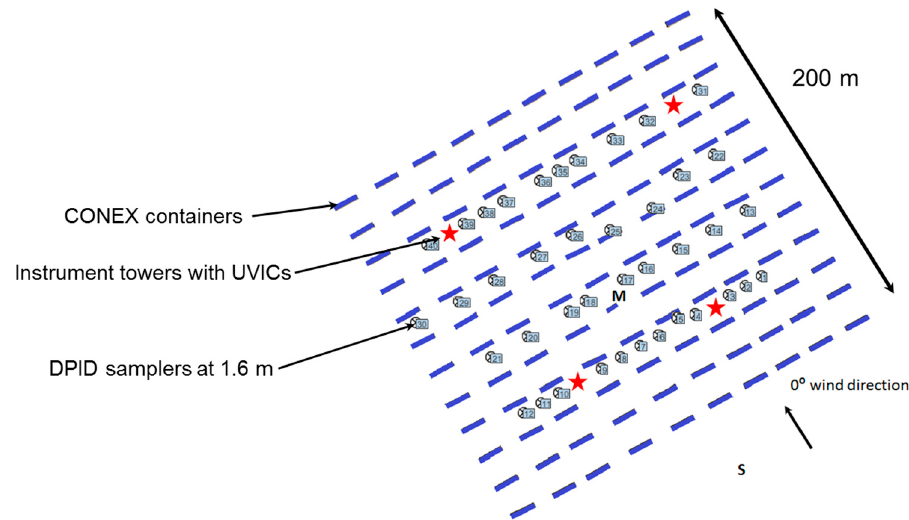
Figure 8. Layout of the CONEX containers in the mock urban setting test (MUST) experiment. From